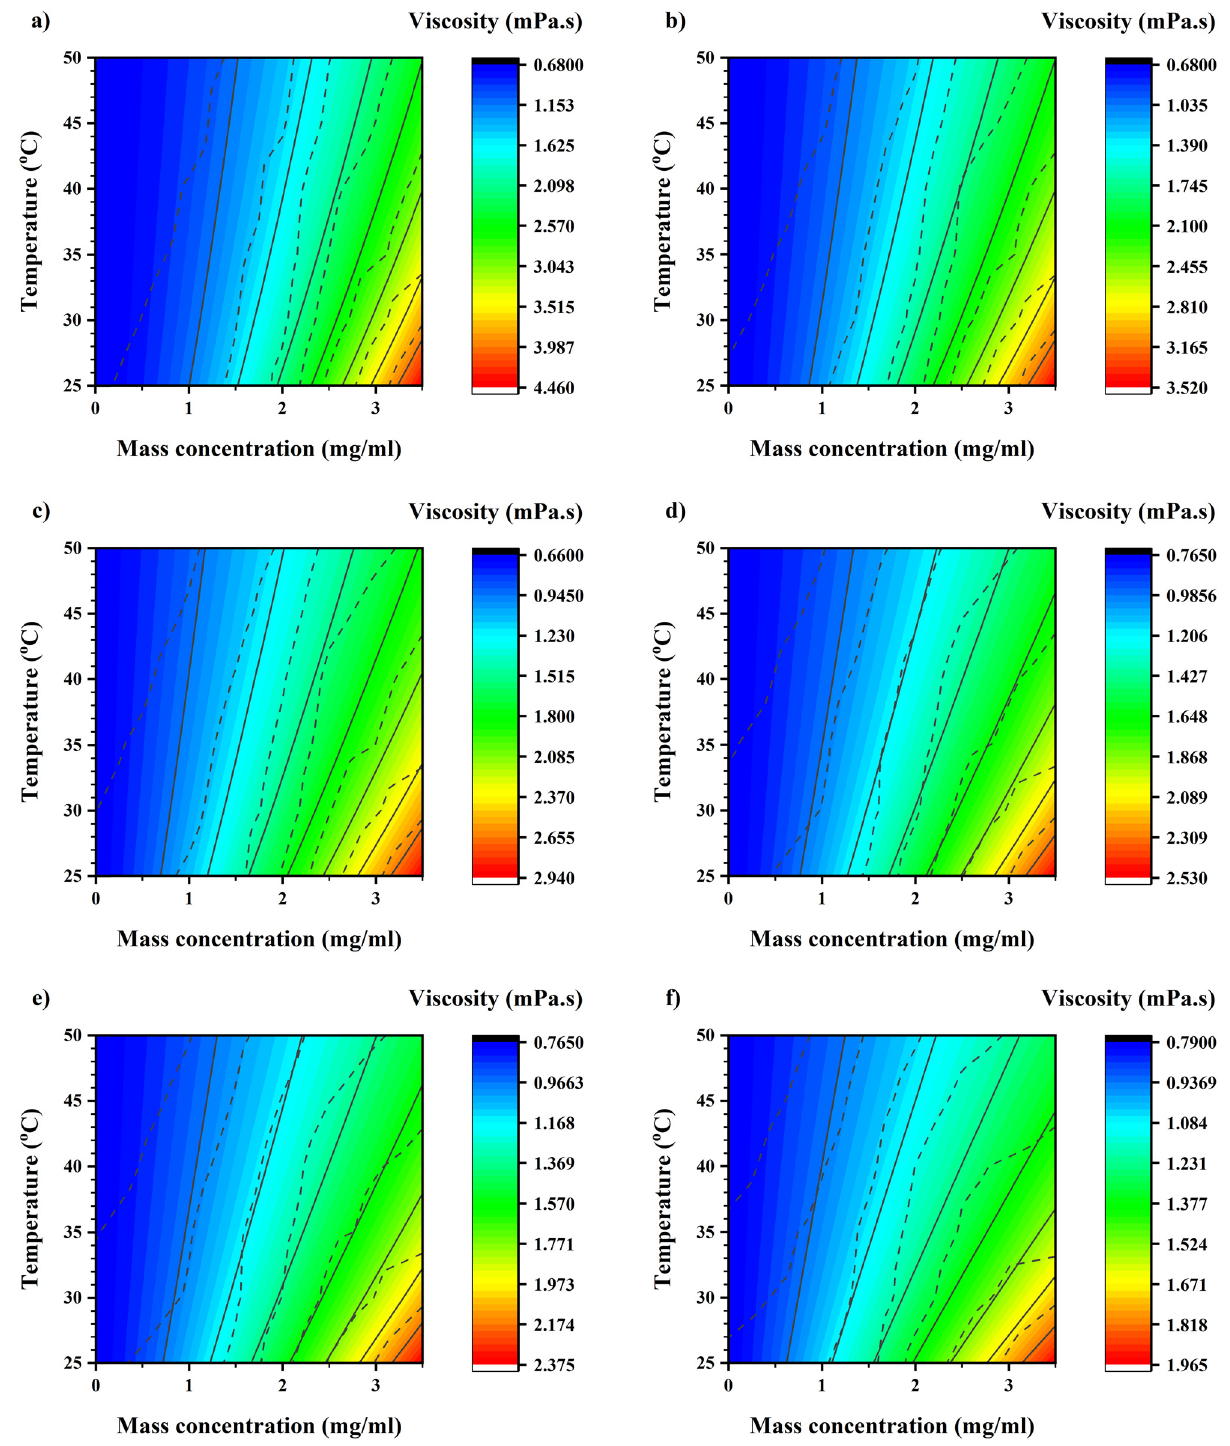
Figure 18: Main outcome ( dashed lines ) and trained outcome ( solid lines ) contour at ( a ) 10, ( b ) 20, ( c ) 30, ( d ) 50, ( e ) 60, and ( f ) 100